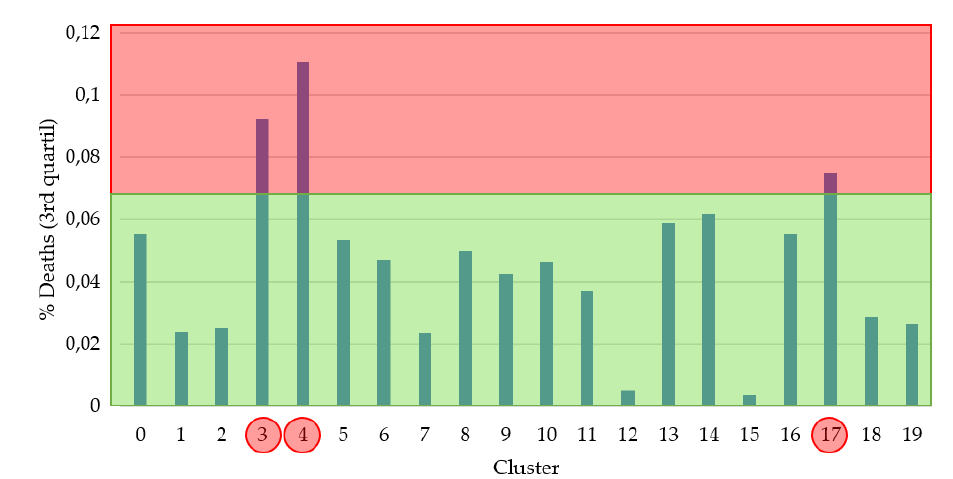
Figure 3. 3rd quartile % of deaths per cluster.The red part represents a high % of deaths and the green part a low one. The red circles show the groups that fall into the red